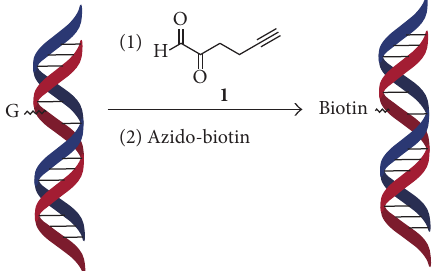
Figure 1: Biotinylation of deoxyguanosine at an abasic site in double-stranded DNA oligonucleotides. The biotinylation of the unpaired deoxyguanosine is achieved by copper-catalyzed click reaction after the conjugation of the oligodeoxynucleotide with 2- oxohex-5-ynal ( 1 ).